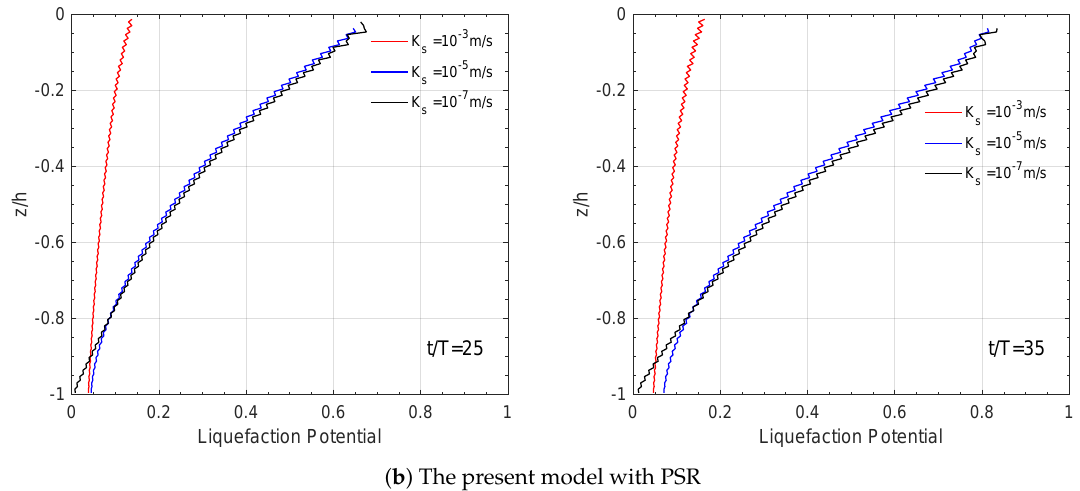
Figure 13. Effect of soil permeability K s considering PSR on the vertical distribution of liquefaction potential on z = − 5 m at four typical time points. ( a ) The original PZIII model without PSR and ( b ) the present model with